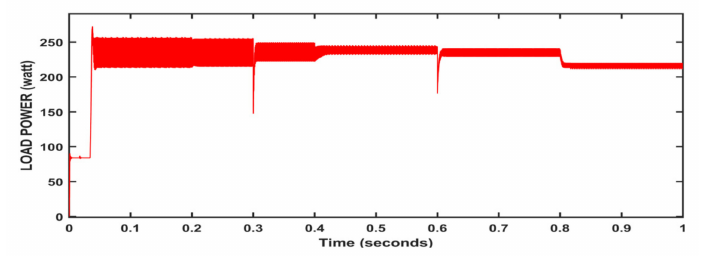
Figure 24. Algorithm performance under variable temperatures and variable